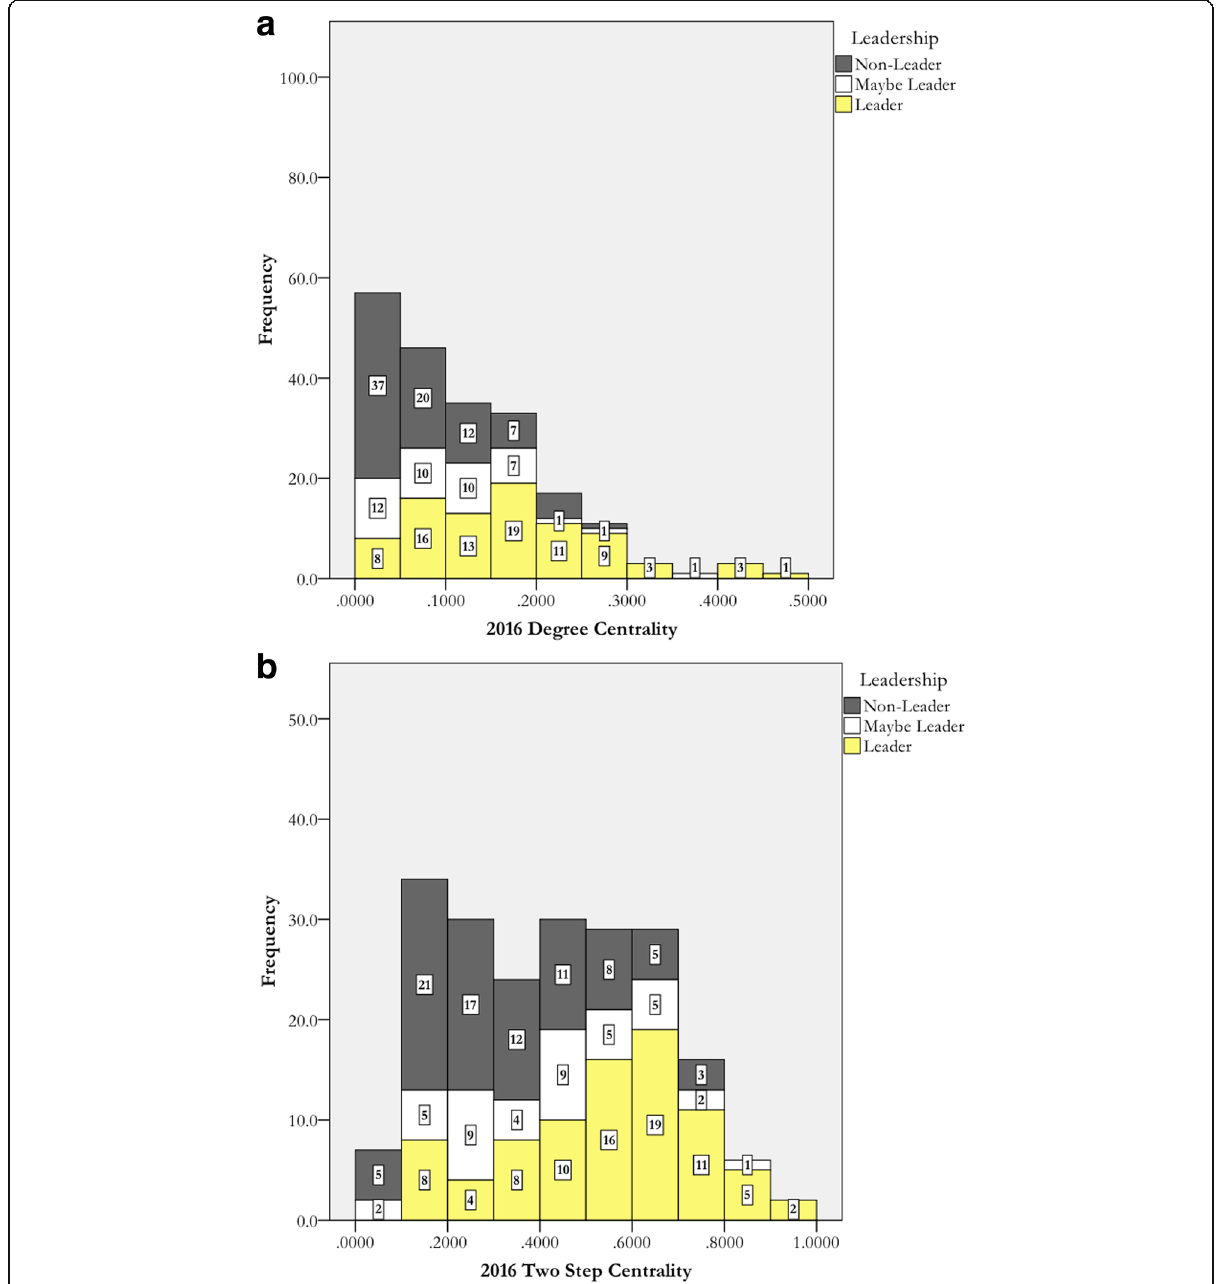
Fig. 4 The 2016 distribution of degree centrality ( a ) and two-step centrality ( b ), with colors indicating leadership